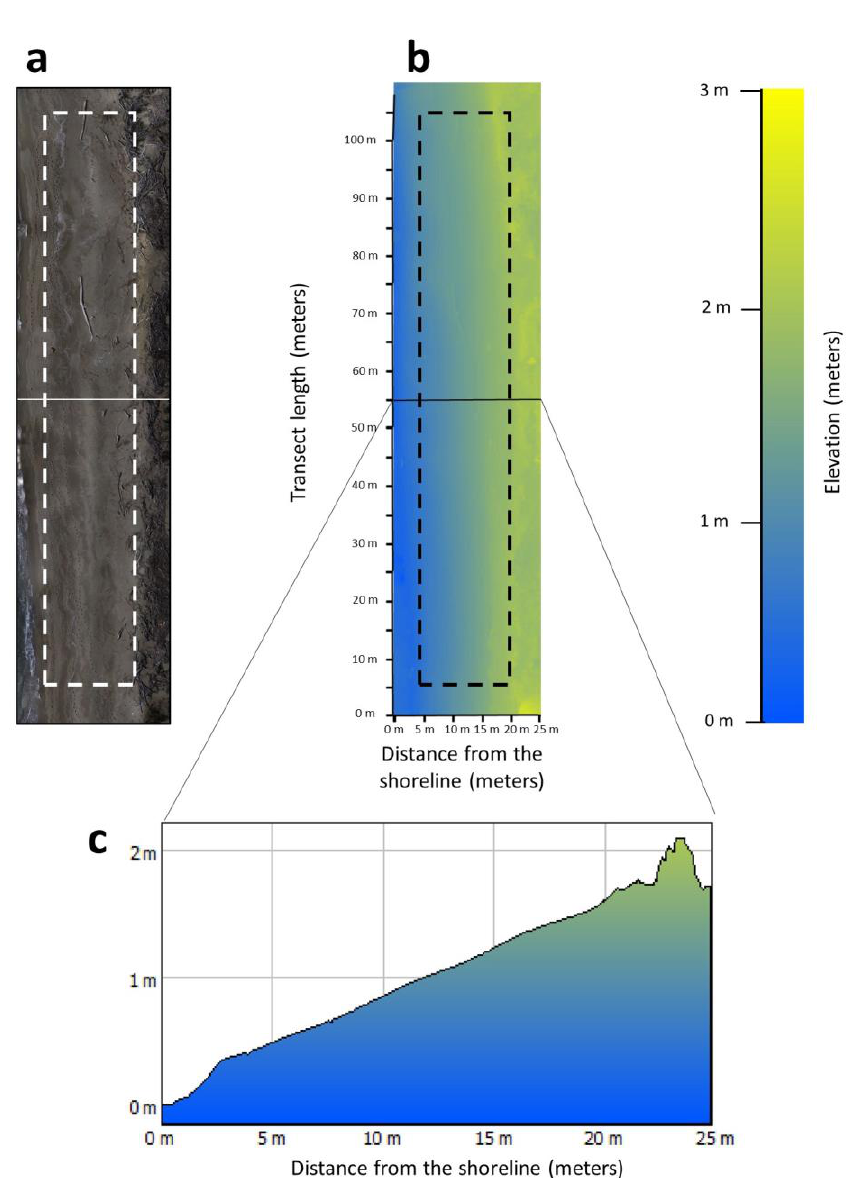
Figure 5. Orthophoto ( a ) and digital elevation models (DEM) ( b ) of the study area, with the profile of the beach corresponding to the central point of the sampled transect ( c ). Distances and elevation are indicated in the image, with the dotted line that delimits the study area inside the beach.